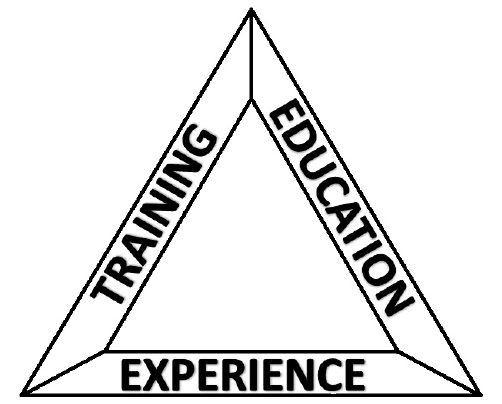
Fig. 1 . The fire professional development triangle as proposed by the Education Committee of the Association for Fire Ecology. Training, experience, and education are all essential components for effective career development in fire (Kobziar et al.